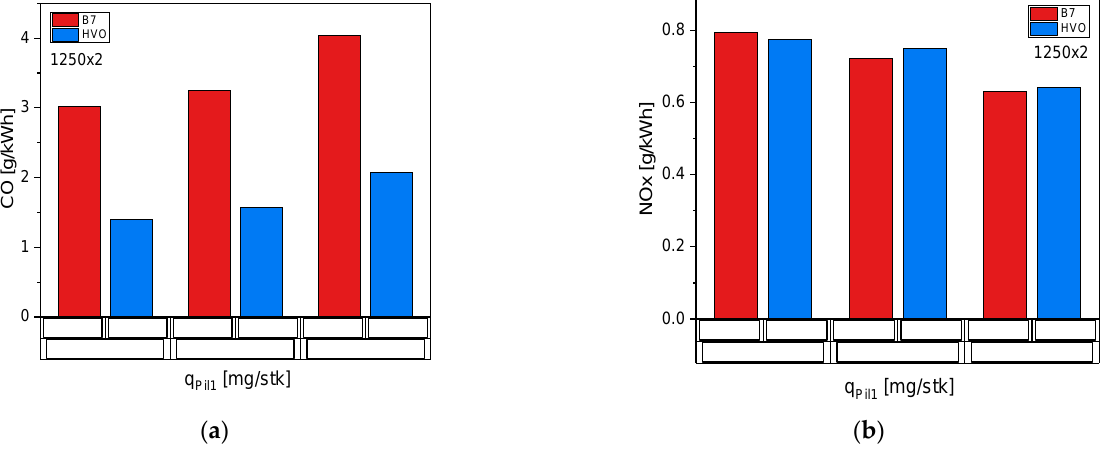
Figure 7. Influence of q Pil1 on CO ( a ) and NO x ( b ) for diesel and HVO at 1250 × 2. At 2250 × 15, the only significant patterns detected were a rather abrupt increase in CN when bigger q Pil1 values were adopted and a corresponding, albeit slight, increase in NO x , indicating the need for relatively small q Pil1 at higher loads.